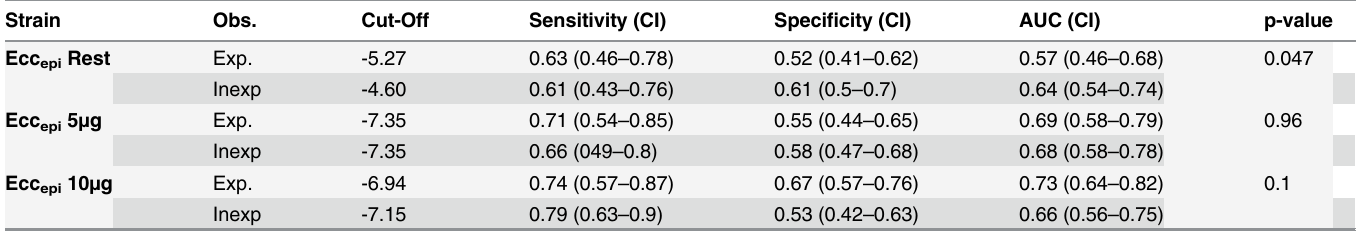
Table 4. The table shows the individual thresholds (cut-off) for left ventricular short-axis subepicardial circumferential strain (Ecc epi ) as assessed by one experienced (Exp.) and one inexperienced (Inexp.) observer (Obs.) at rest and with 5 and 10 μ g of dobutamine. Strain Obs. Cut-Off Ecc epi